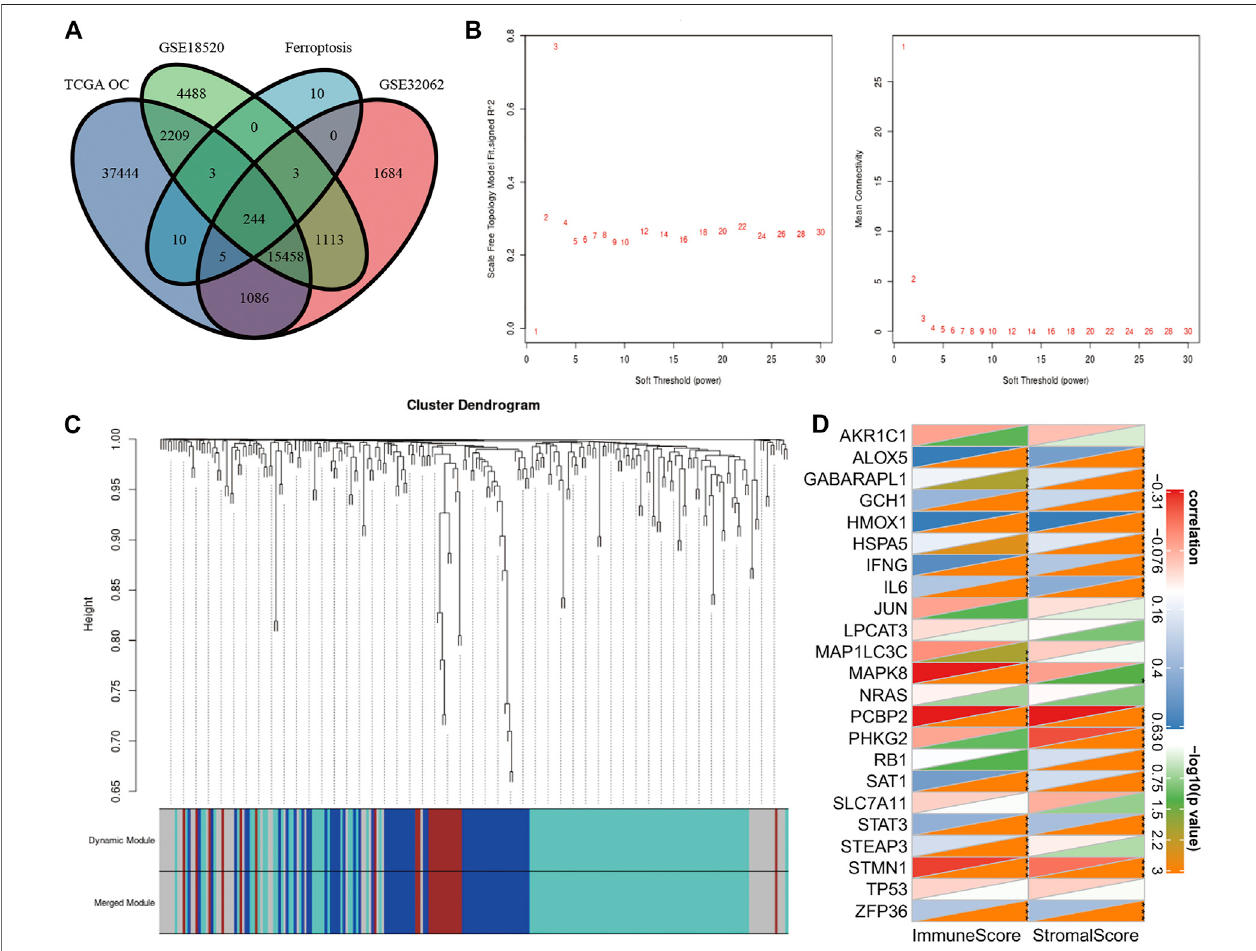
FIGURE 5 | (A) Venn diagrams are used to show the overlapping FRGs in FerrDb, TC GA OV, GSE18520, and GSE32062. (B) Scale-free fi t index for soft- thresholding powers. Ordinate on the left represents the square of the correlation coef fi cient between log (k) and log [p (k)] in the FRG network. Ordinate on the right represents the mean value of the adjacent function of all genes in the corresponding gene module. (C) Cluster dendrogram of ferroptosis-related genes. Each branch represents a gene, and the colors below represent speci fi c co-expression modules. (D) Pearson ’ s correlation analysis between 23 ferroptosis-related genes and the results calculated by ESTIMATE. * p < 0.05, ** p < 0.01, and *** p <